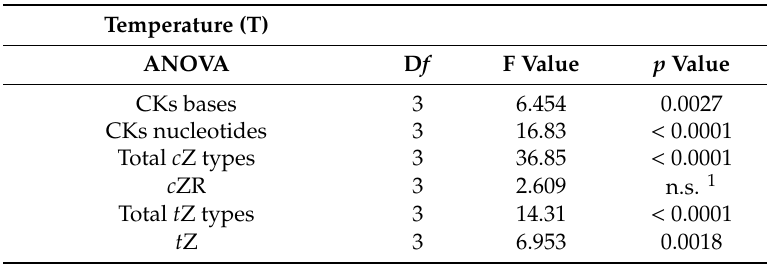
Table 5. One-way analysis of variance for concentration of endogenous isoprenoid